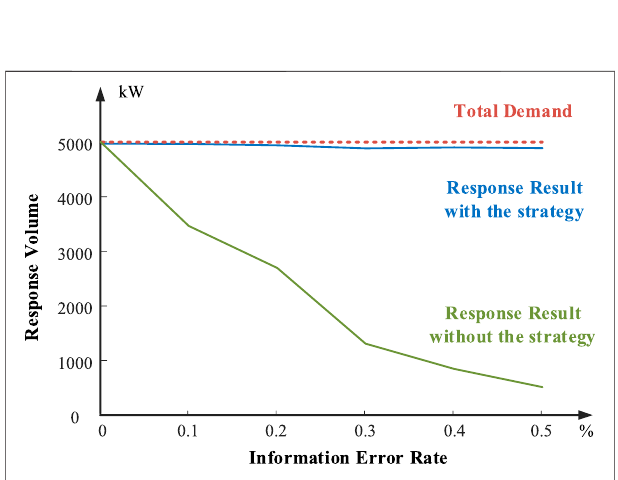
FIGURE 13 | Comparison between adopting the proposed strategy or not in Case 2.